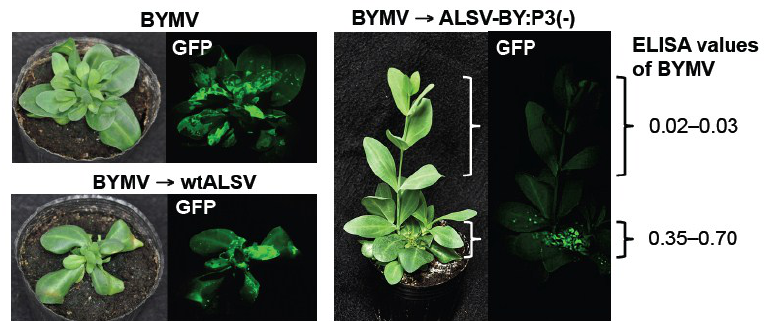
Figure 6. Curative effect of post-inoculation with an Apple latent spherical virus (ALSV) vaccine (ALSV-BY:P3(−)) on Bean yellow mosaic virus (BYMV) multiplication in mosaic-diseased eustoma plants infected with BYMV expressing green fluorescent protein (GFP). Pictures were taken at one month post-inoculation with the ALSV vaccine. In